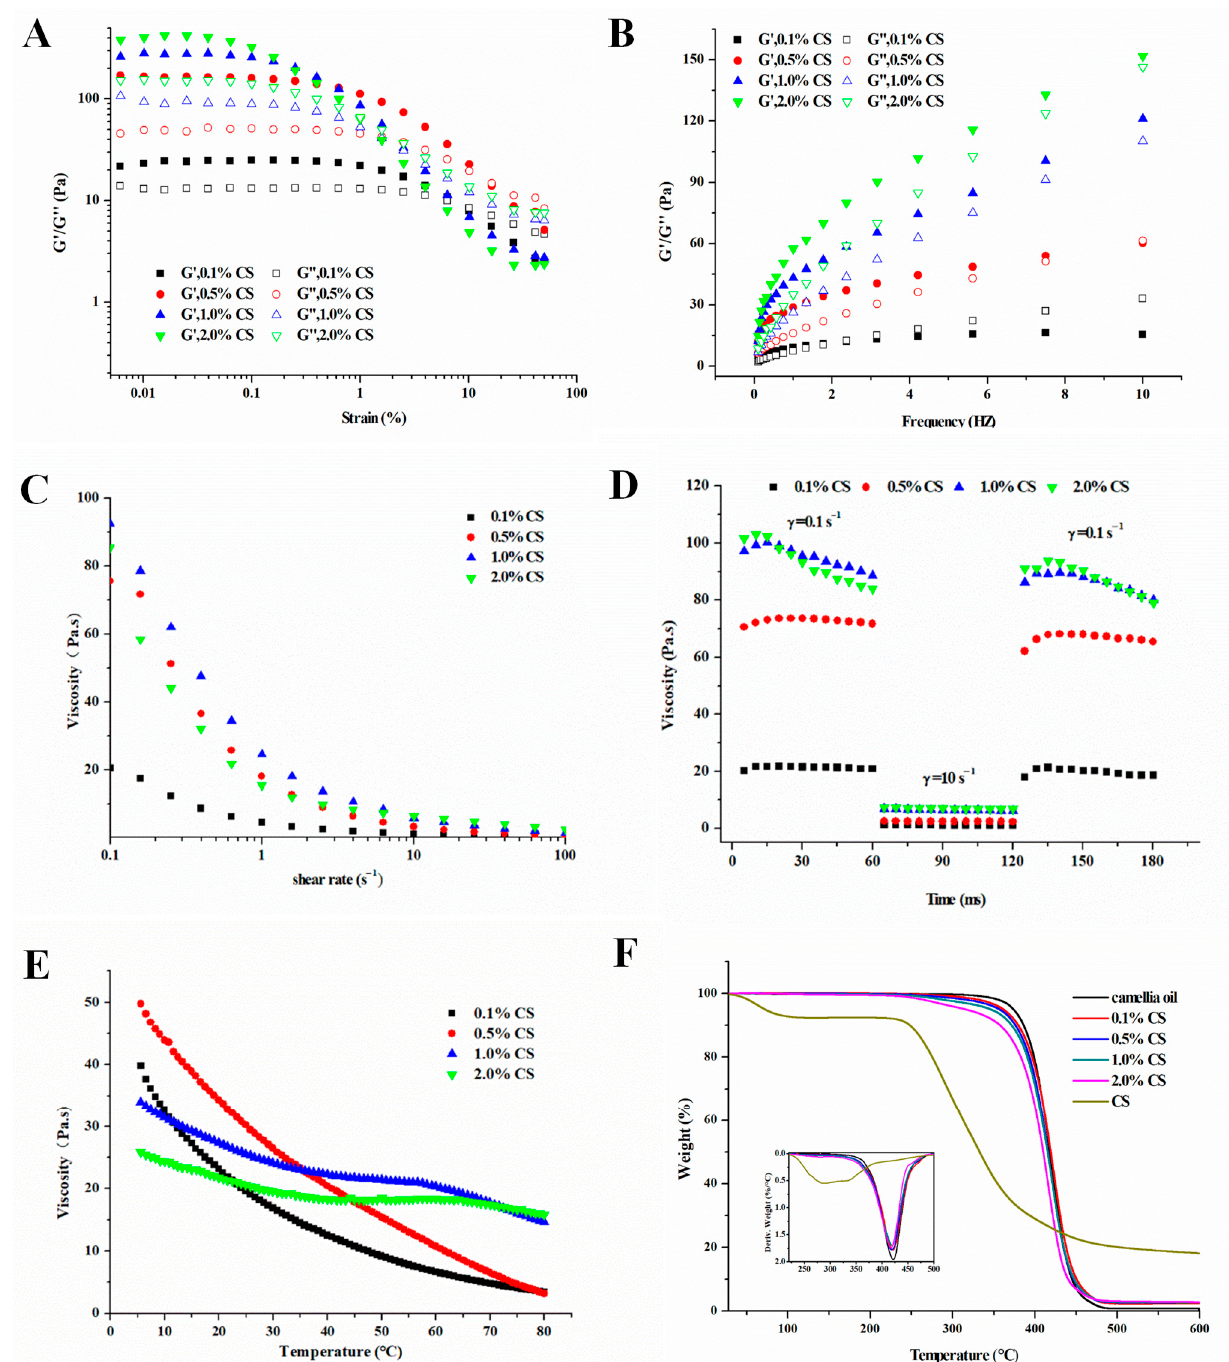
Figure 6. Strain sweeps ( A ), frequency sweeps ( B ), viscosity curve ( C ), thixotropic recovery curves ( D ), and temperature sweeps ( E ) and TG curves ( F ) of oleogels from COBET with different CS